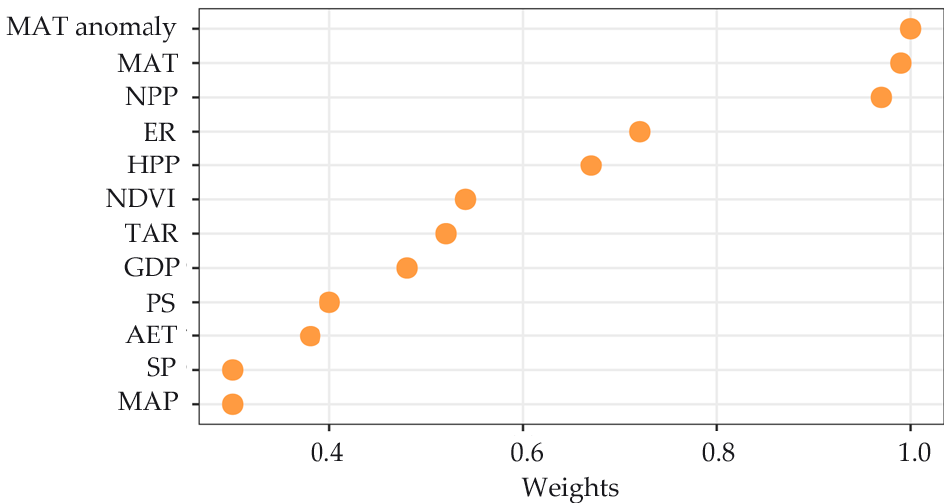
Figure 4. Planthopper species richness patterns in a 1° grid size.